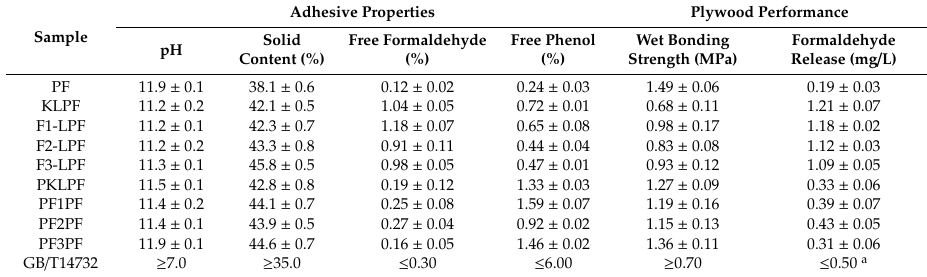
Table 1. The Properties of Lignin and Phenolated Lignin-Based Adhesive and the Performances of